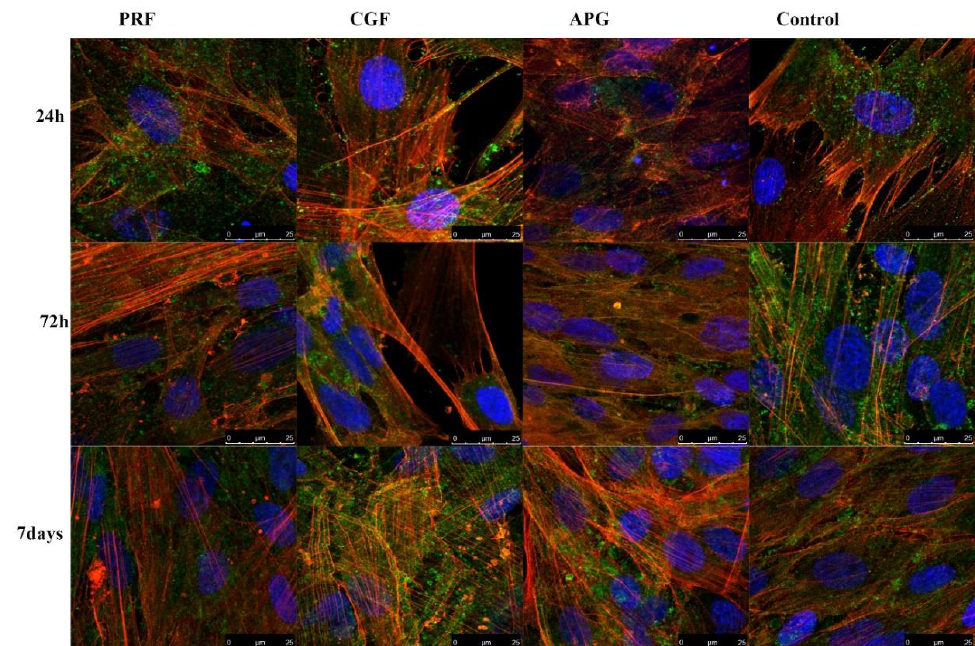
Figure 5. CLSM representative pictures, at a higher magnification, of actin filaments in treated HPLF and control. It is worth noting how in the CGF 72 h observations, the spaces between the cells are filled with large cytoplasmic extensions, displaying a delicate and uniform red signal.